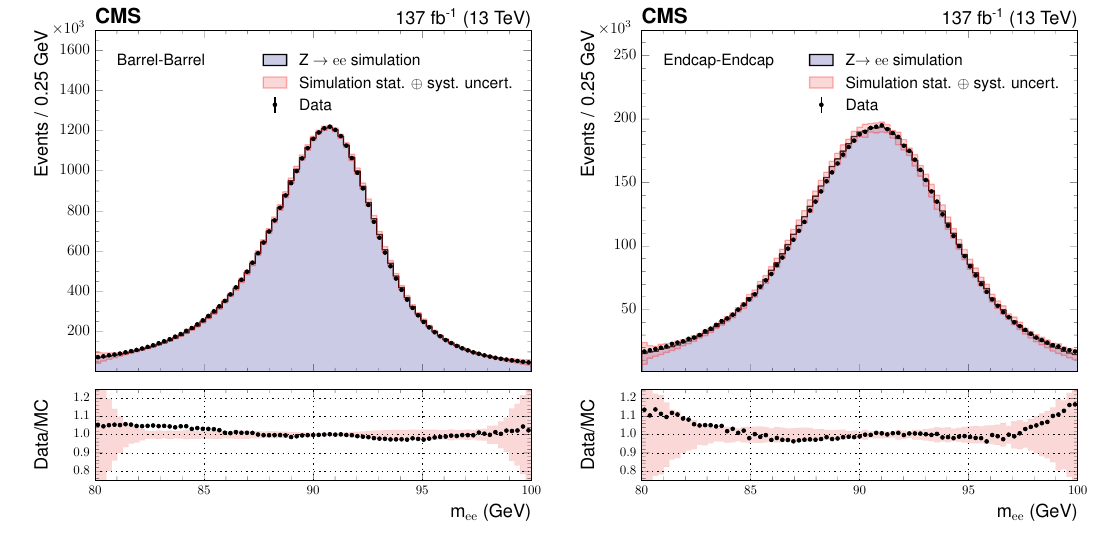
Figure 2 . Comparison of the dielectron invariant mass spectra in data (black points) and simula- tion (blue histogram), after applying energy scale corrections to data and energy smearing to the simulation, for Z → ee events with electrons reconstructed as photons. The statistical and system- atic uncertainty on the simulation is shown by the pink band. The comparison is shown for events where both electrons are reconstructed in the ECAL barrel (left), and both in the ECAL endcaps (right). The lower panels show the ratio of the data to the MC simulation in black points, with the uncertainty on the ratio represented by the pink band. The full data set collected in 2016–2018 and the corresponding simulation are